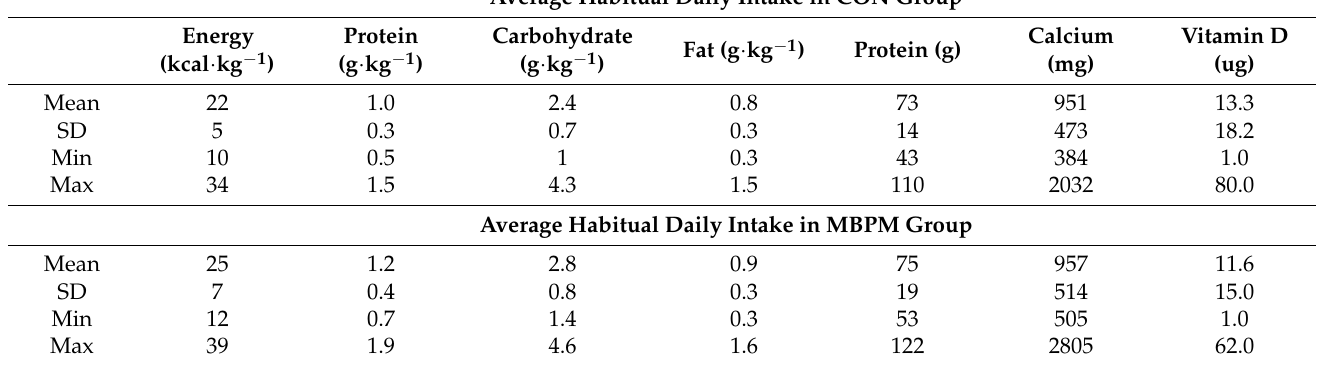
Table 2. Baseline 7-day averaged daily nutrient intake for the calcium-fortified, milk-derived protein matrix (MBPM) and maltodextrin (CON) groups ( n = 55).